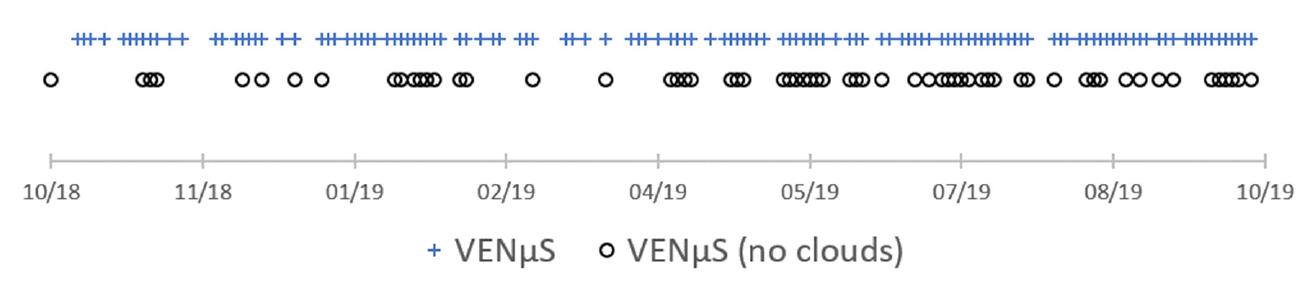
Figure 5. Data availability of VEN µ S for the TimeSat pixel-based analysis of seasonality. The first (NDVI) date was produced as an average of two neighbor clear dates (11 September 2018 and 29 October 2018).